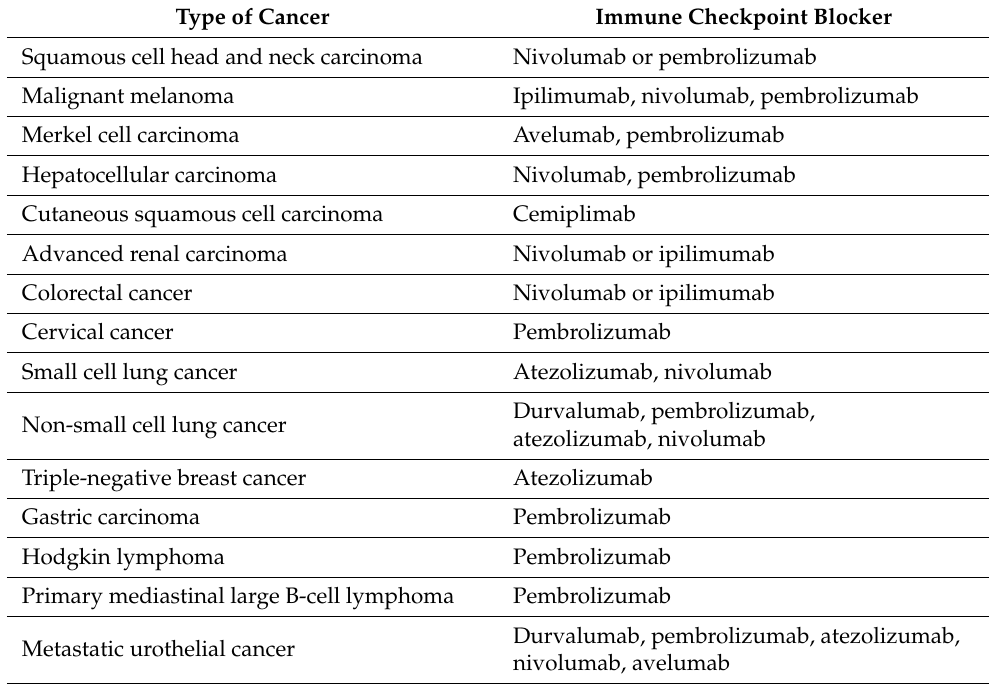
Table 1. FDA-approved immune checkpoint